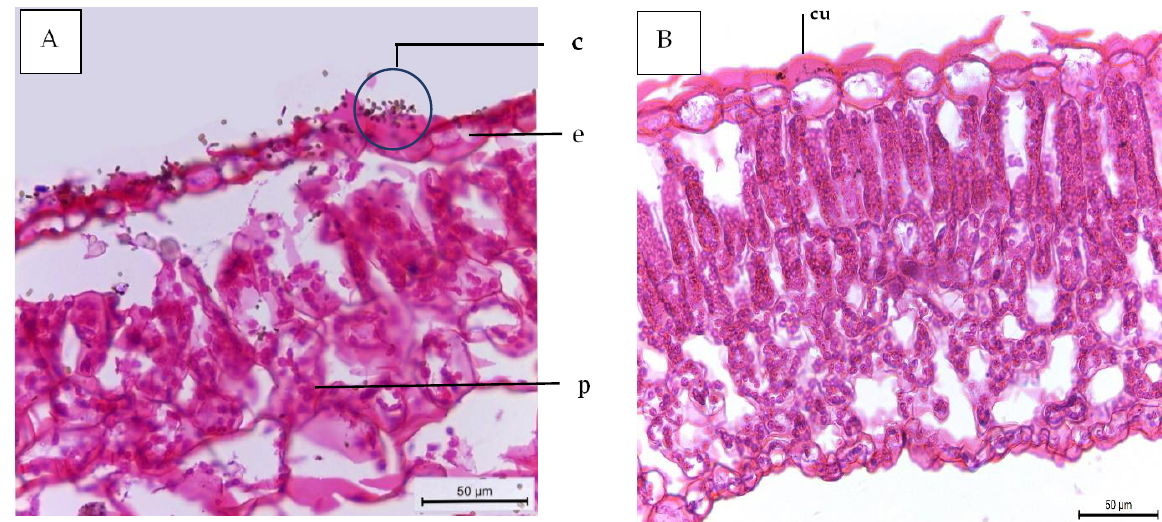
Figure 11. Magnified portions of the leaf blade lamina of summer squash (cv. Eskandarani), aged 50 days. Scale bars = 50 µm. ( A ) Plants affected by powdery mildew (control). ( B ) Plants treated by mix between 40 ppm SA and (SR + TS). Abbreviations: cu — cuticle; e — epidermis; c — conidia; and p — plastids. Table 7. Counts and measurements in micrometers ( m) of certain histological characters in trans- verse sections through the blade of the fifth leaf developed on the main stem of summer squash (cv. Eskandarani), aged 40 days, affected by powdery mildew as a control and treated with shikimic acid, bioagent ( S. rochei + T. Asperullum ), and a mix between them (Means of three sections from three specimens).